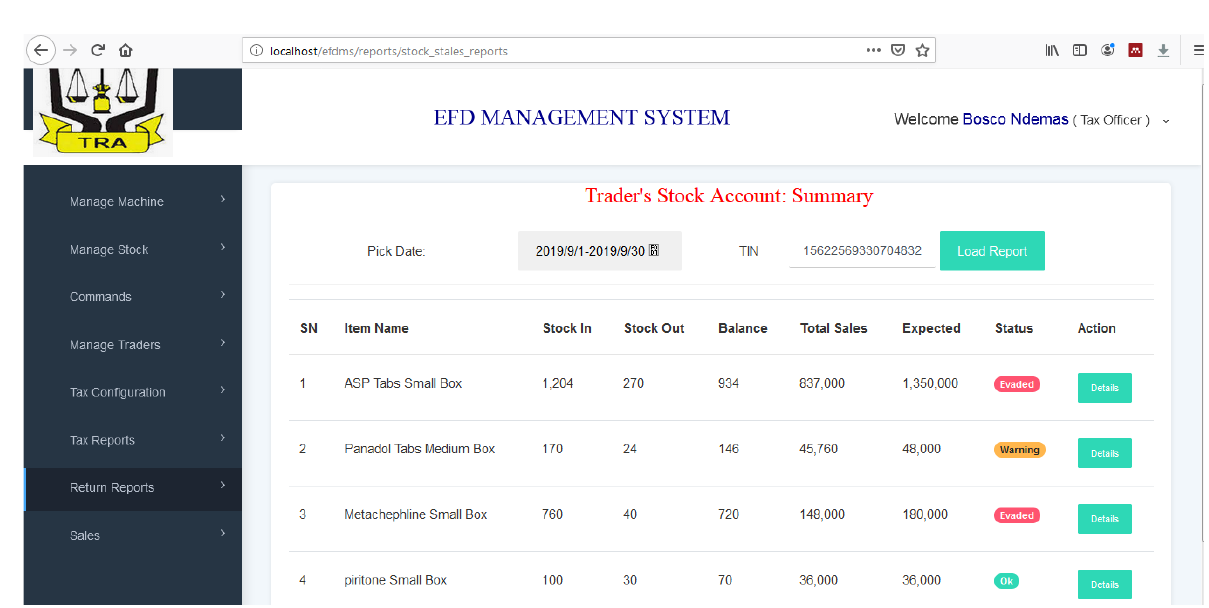
Figure 10. Local manufacturer registering stock to EFDMS